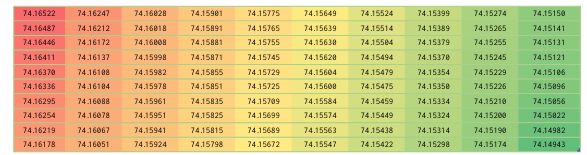
Table 5. Slopes of the fitting straight lines on the right image of the GeoEye dataset (degree)